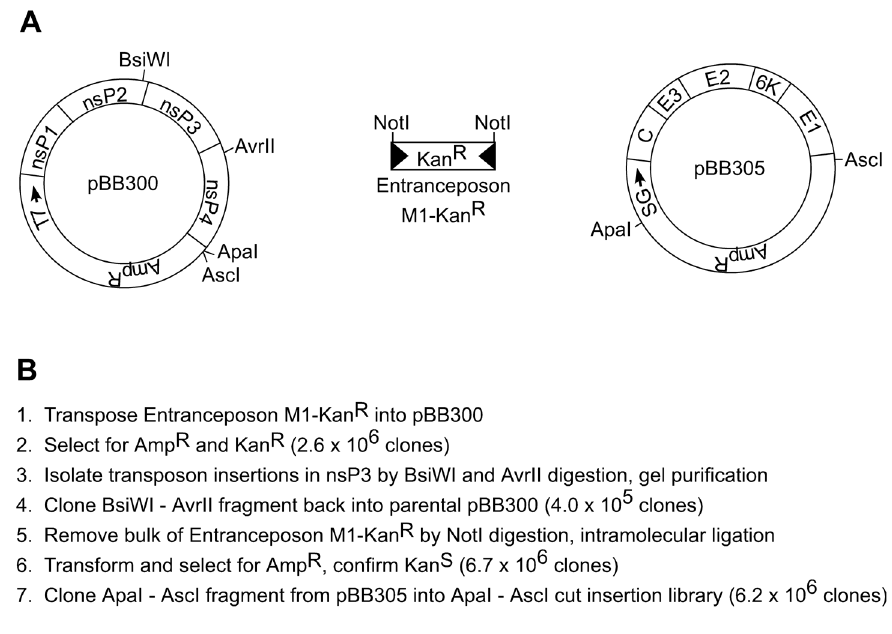
Figure 1. Generation of VEEV nsP3 insertion library. Entranceposon M1 – Kan R was transposed into pBB300 and then processed to generate a library of clones that contained 15 base-pair inserts in nsP3 (and short flanking regions in nsP2 and nsP4). (A) Diagram of plasmids pBB300 and pBB305 and Entranceposon M1 – Kan R . T7 - T7 promoter; nsP1-nsP4 – VEEV non-structural proteins; SG – VEEV subgenomic promoter; C, E3, E2, 6K, E1 – VEEV structural proteins. (B) Procedure for making full-length VEEV library with short insertions in